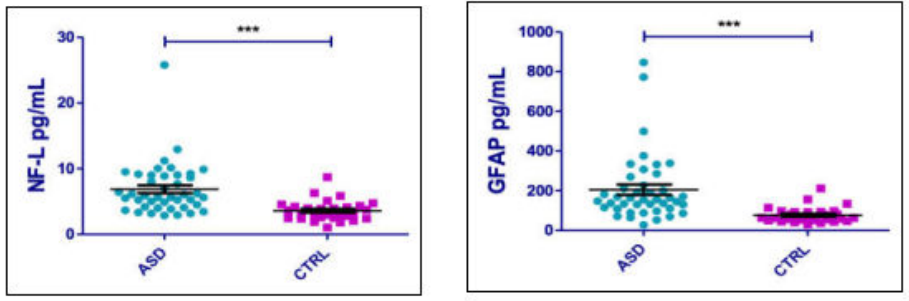
Figure 1. Comparisons of sNfl ( a ) and sGFAP ( b ) values between ASD patients and control group. Mann Whitney test *** p value <